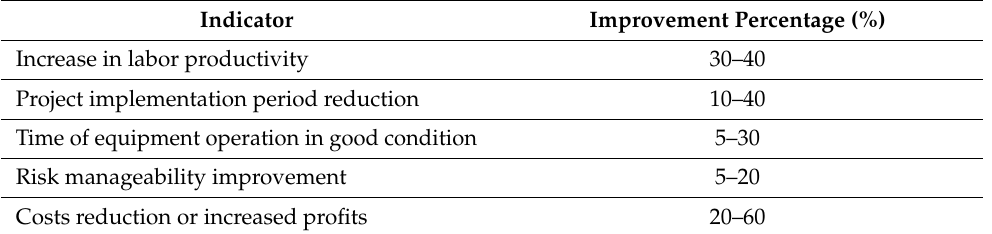
Table 3. Indicators of construction processes improvement according to the lean construction